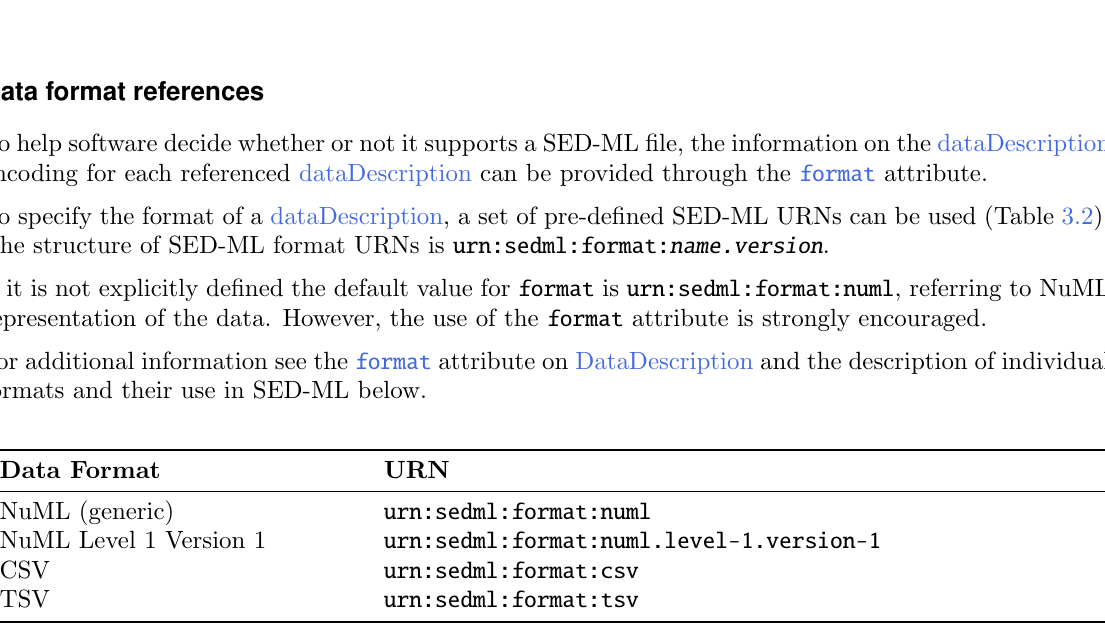
Table 3.1: Predefined model language URNs. The latest list of language URNs is available from http://sed-ml.org/ .